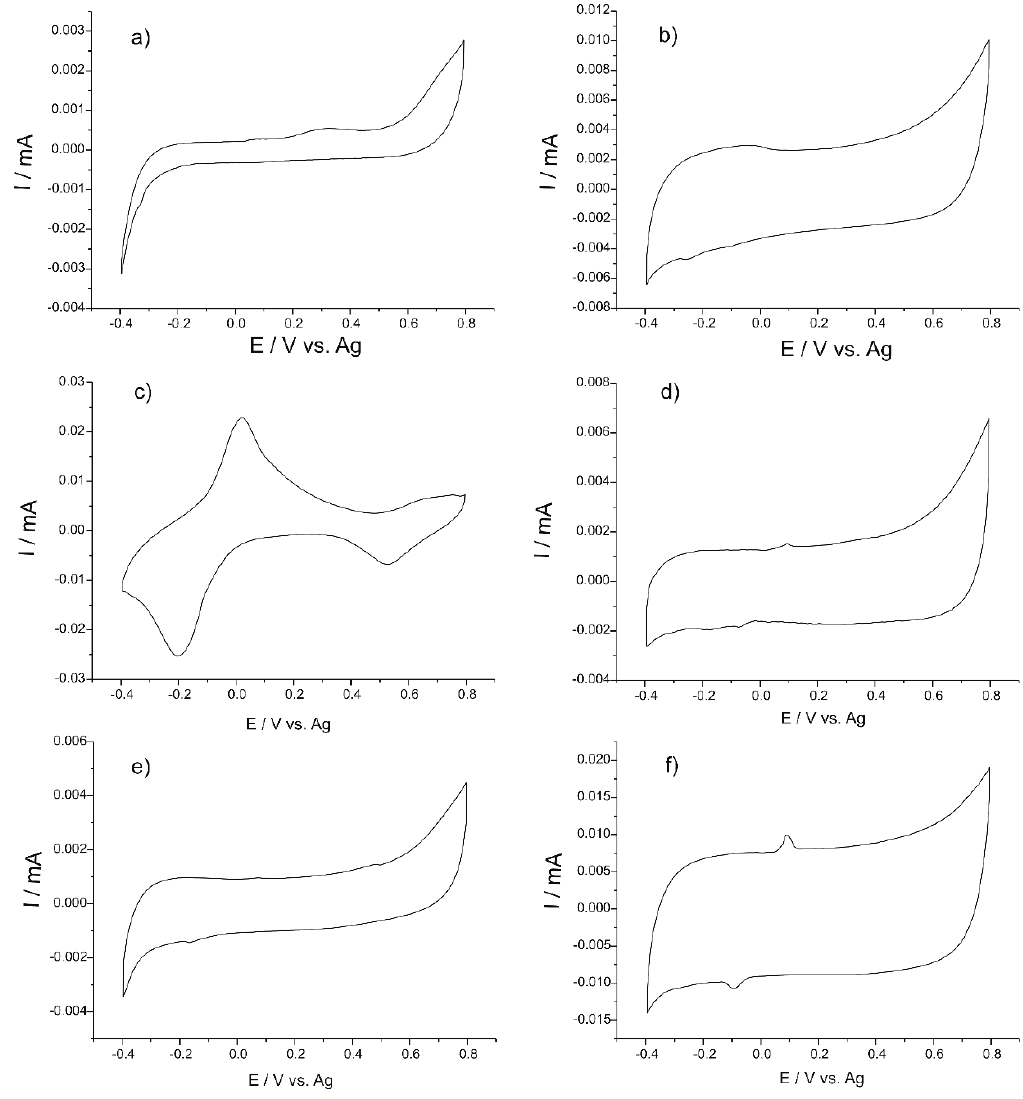
Figure 1. Sensor response ( a ) CoPc-SPE; ( b ) MB-SPE; ( c ) PB-SPE; ( d ) MWCNT/GNP-SPE; ( e ) MWCNF/GNP-SPE; ( f ) MWGPH/GNP-SPE exposed to the DL water sample.